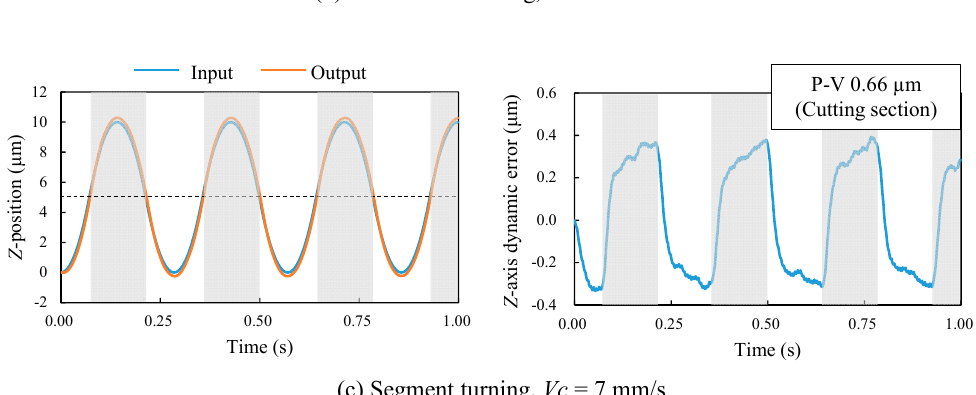
Figure 14. Calculated Z -axis positions (left-side graphs) and position errors (right-side graphs) for continuous turning and segment turning using an STS system. ( a ) Continuous turning, Vc = 7 mm/s; ( b ) continuous turning, Vc = 2.3 mm/s; ( c ) segment turning, Vc = 7 mm/s.